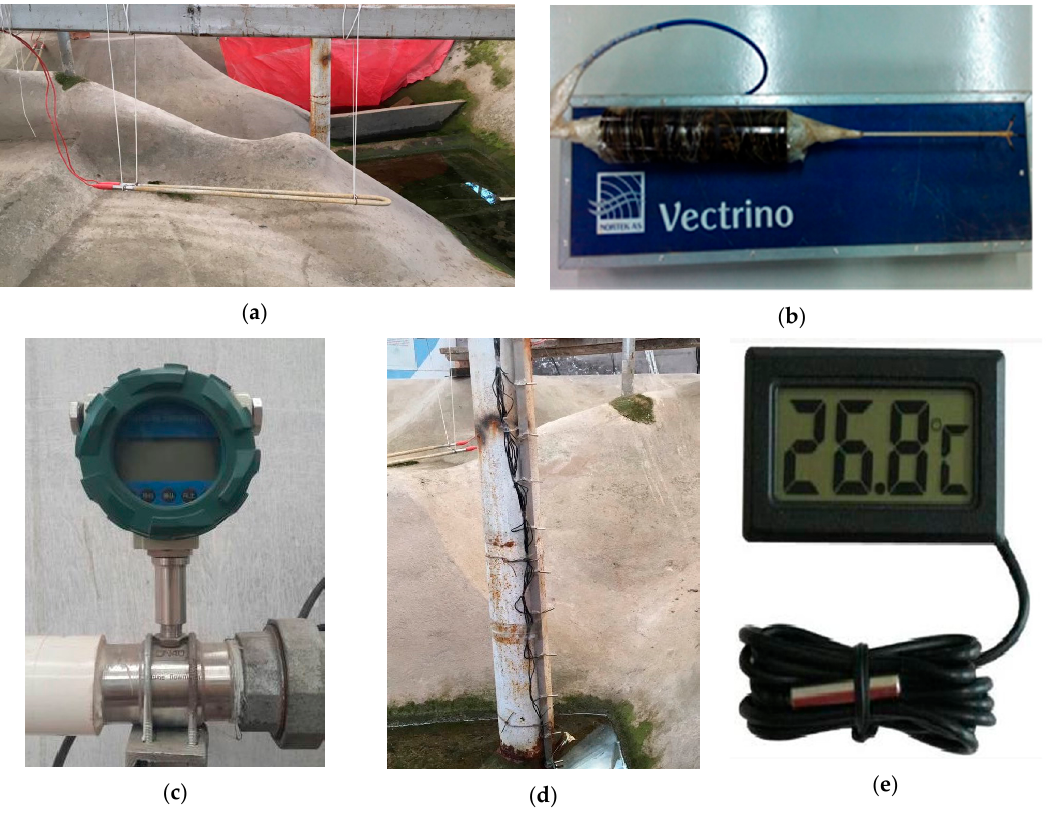
Figure 7. Experimental measuring instruments: ( a ) Electric heating tube, ( b ) ADV, ( c ) Turbine flowmeter, ( d ) Probe arrangement of water temperature sensors, ( e ) Temperature sensor.